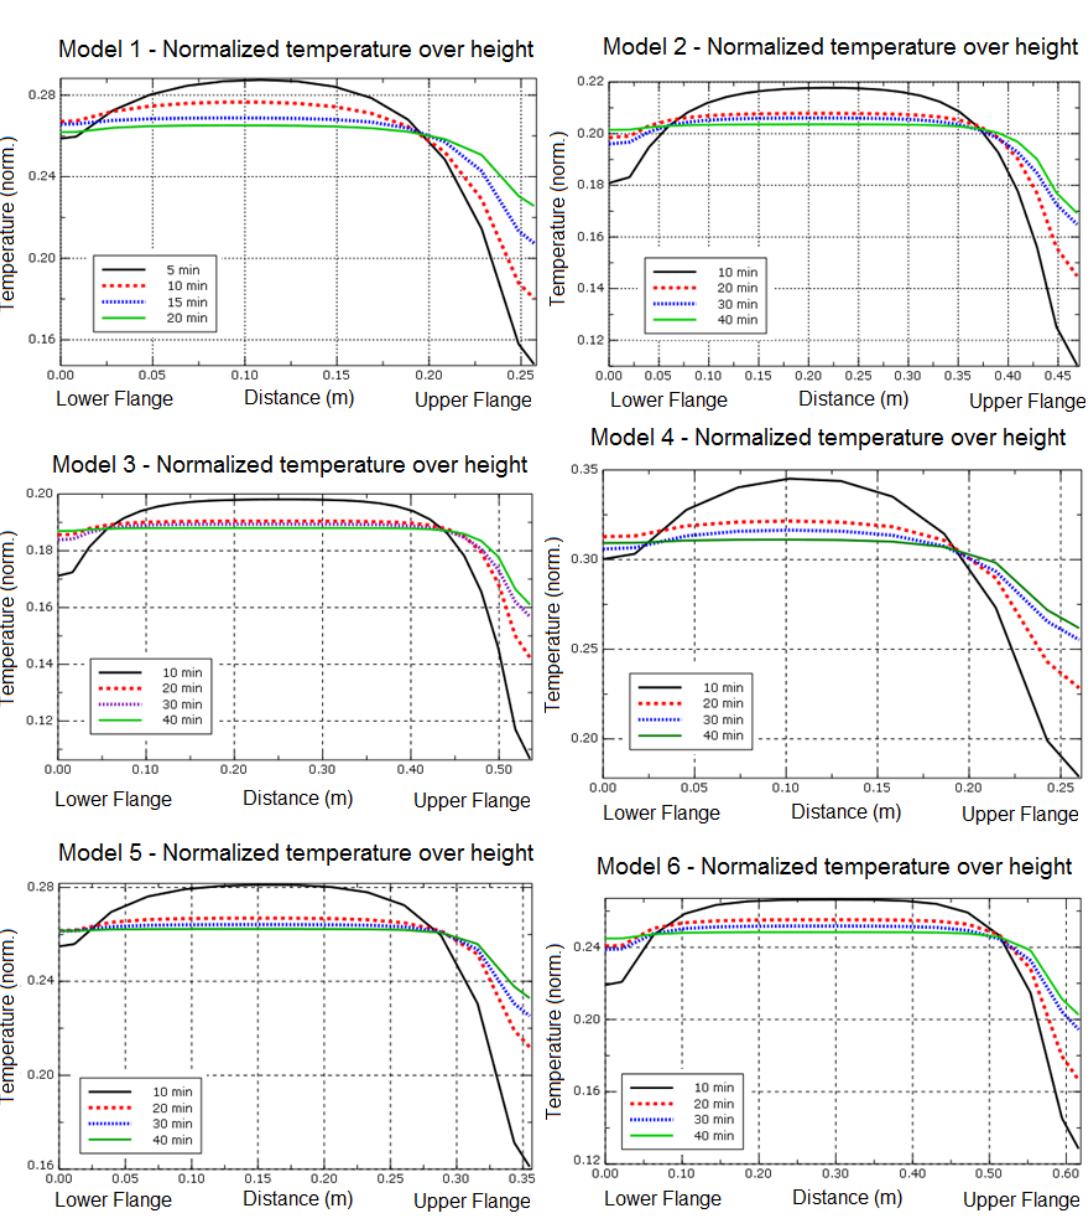
Figure 14. Normalized temperature over